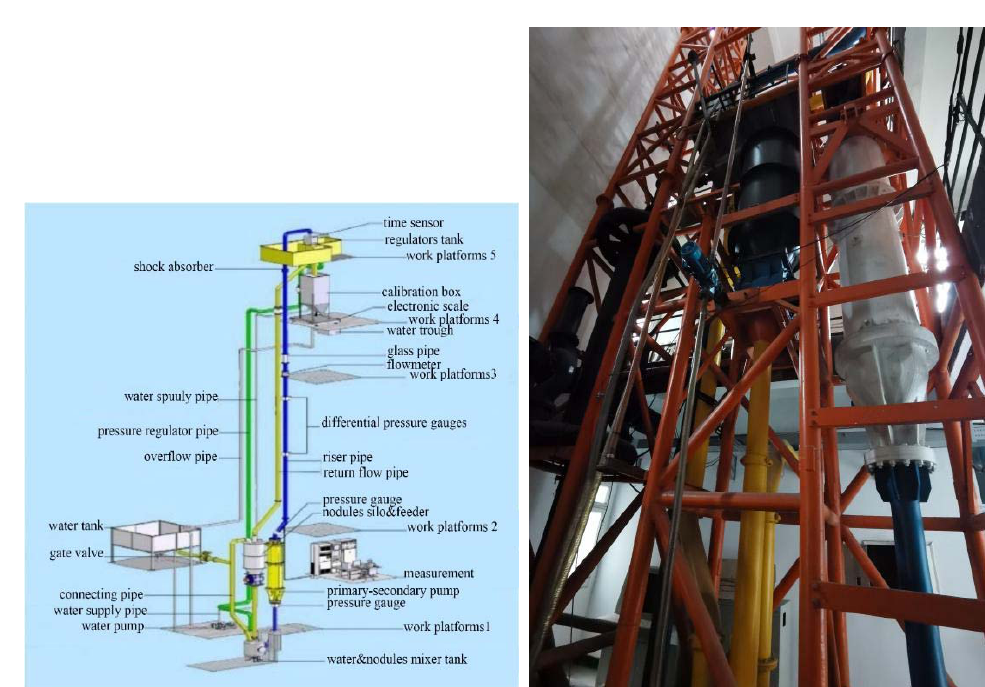
Figure 5. Layout of the experimental system.